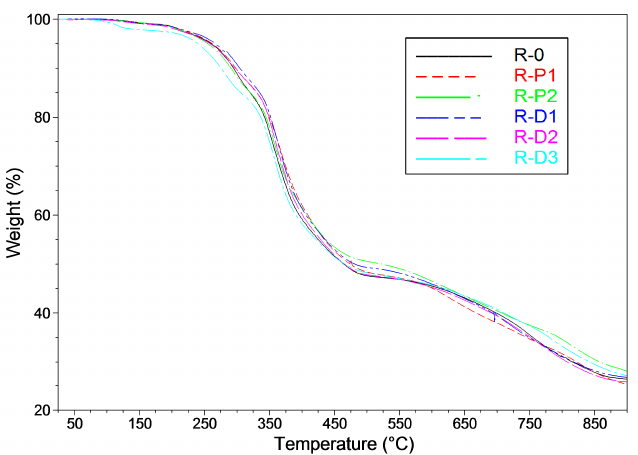
Figure 7. Thermogravimetric curves for intumescent coatings with CNTs or PER-CNTs solid dis-